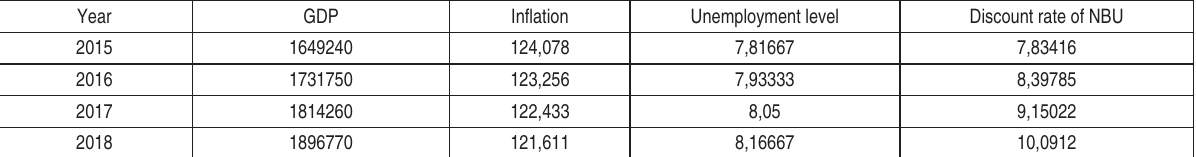
Table 7. Projected values influencing the development of the credit market of Ukraine